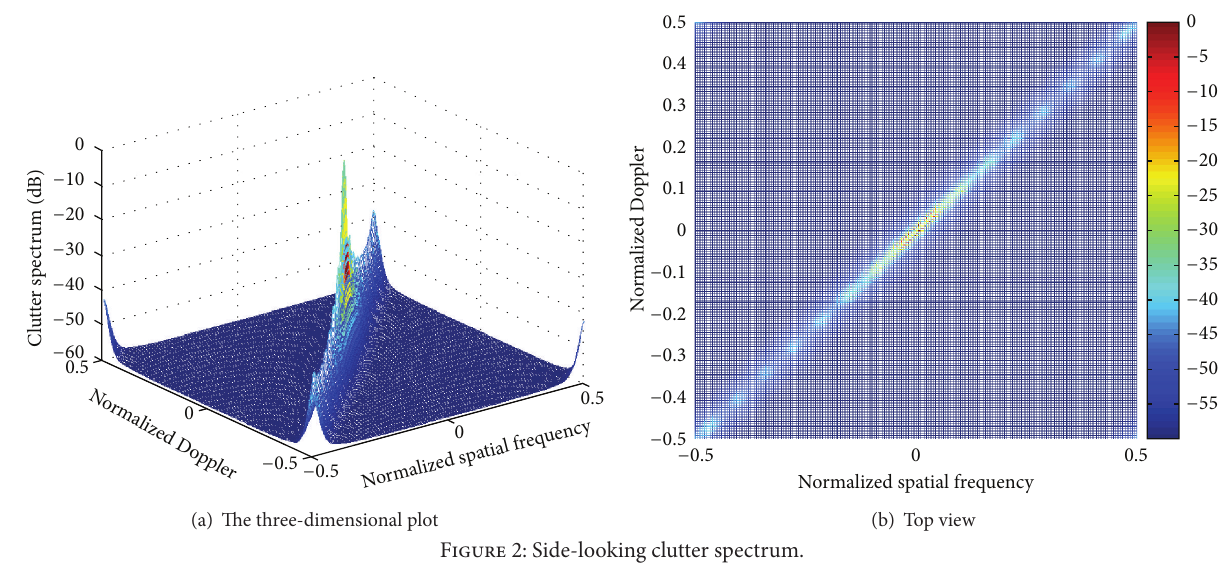
Figure 2: Side-looking clutter